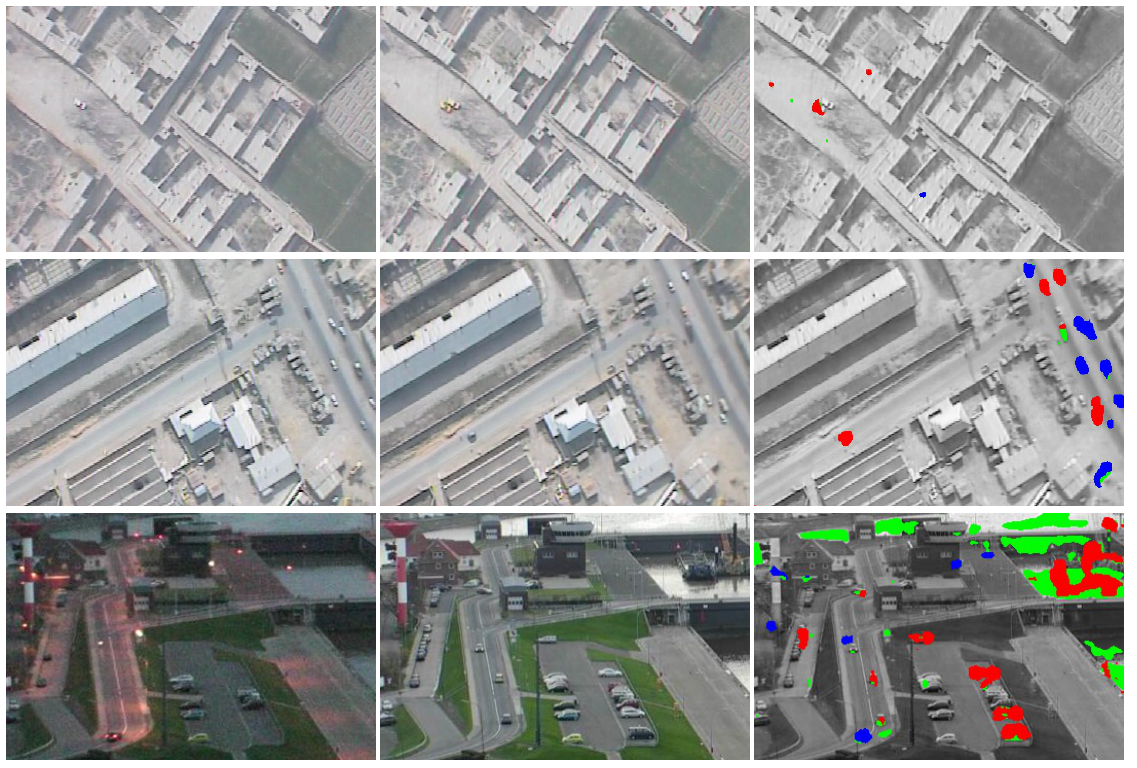
Figure 3: Change detection results for urban scenes in Nadir view from UAV (1st and 2nd row) and from a fixed sensor position in oblique view at different daylight time (3rd row): Subframes of registered originals (1st and 2nd column) and combined change masks (3rd column) over input gray image using the same color coding as in Figure